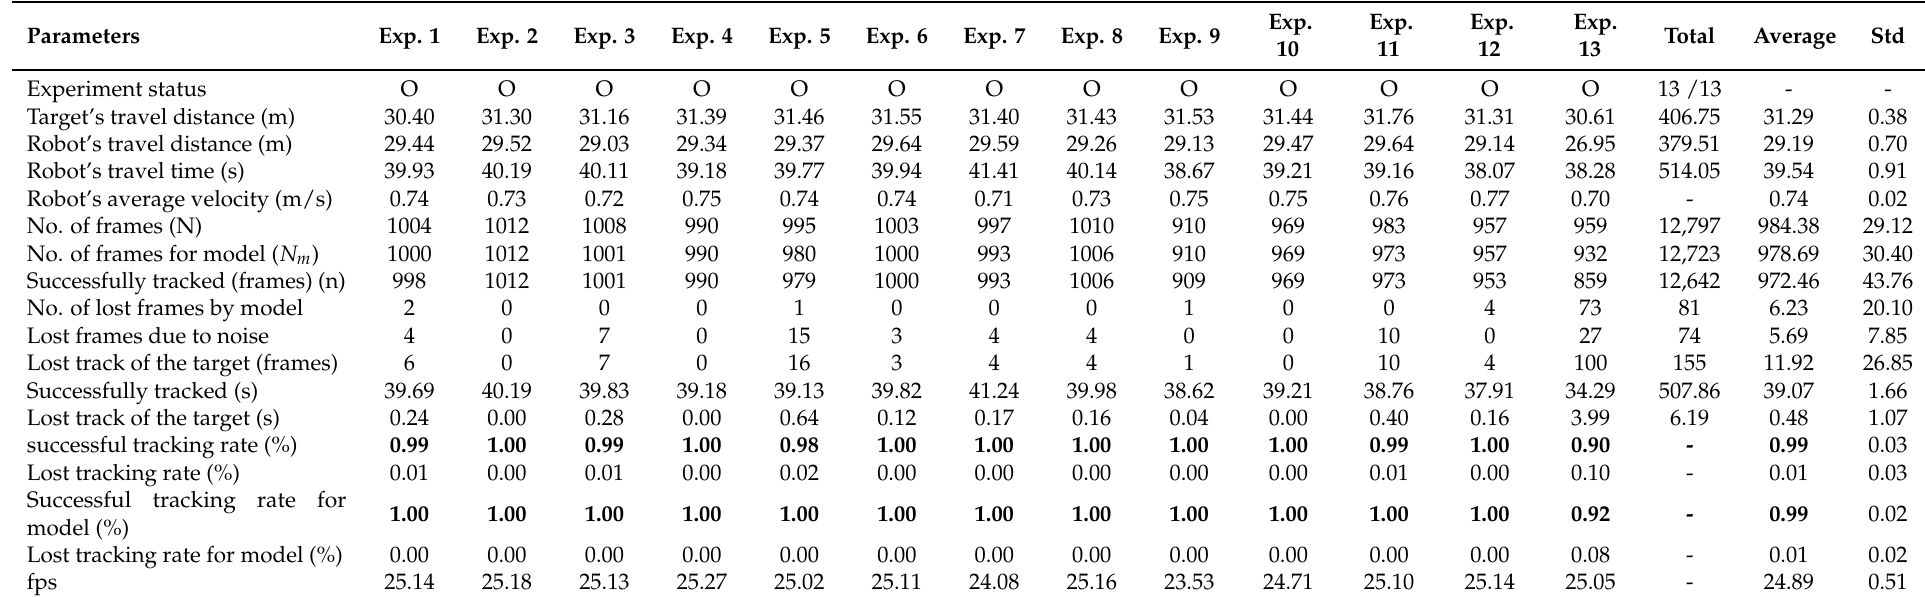
Table 2. Experimental results for the blue color.